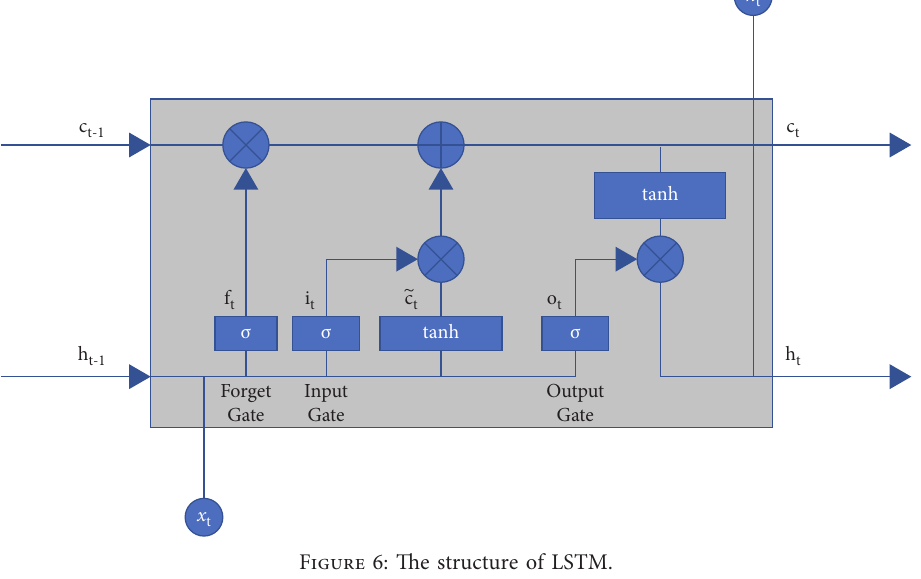
Figure 6: The structure of LSTM.